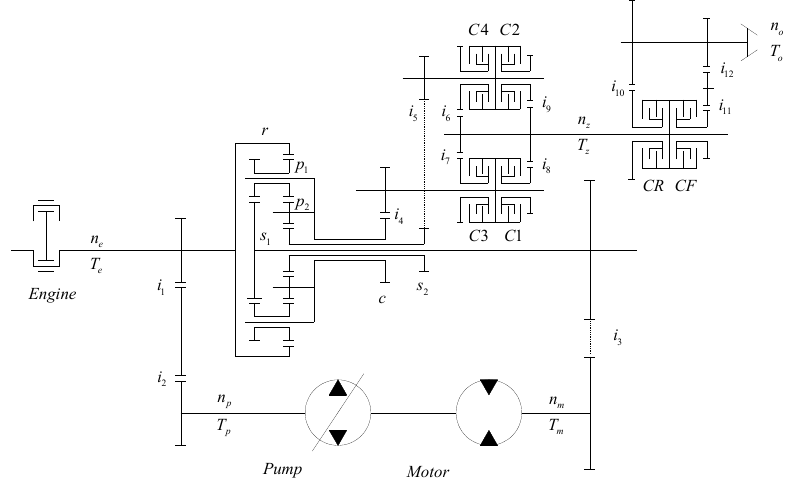
Figure 1. HMCVT stick diagram.